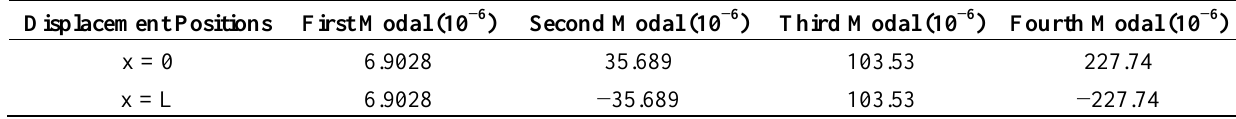
Table 5. The boundary displacements of first four modal